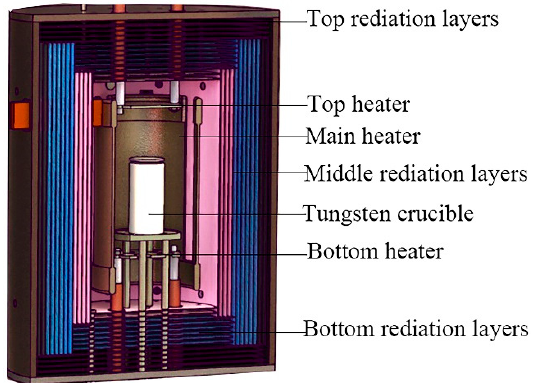
Figure 1. Schematic diagram of AlN crystal-growth furnace.